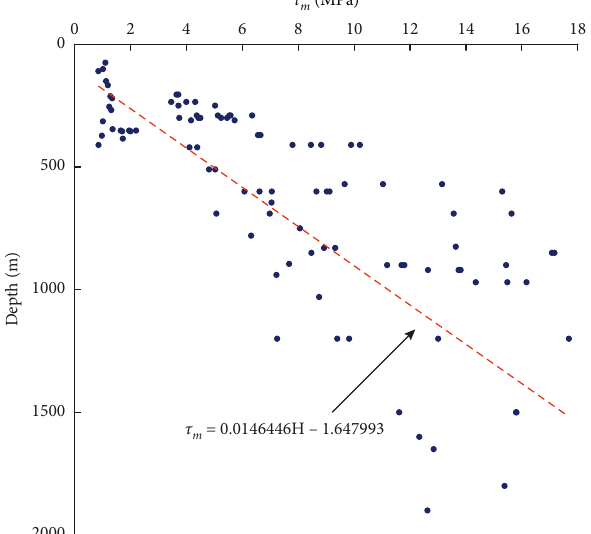
Figure 10: Distribution characteristics of the maximum horizontal principal stress direction in Shandong